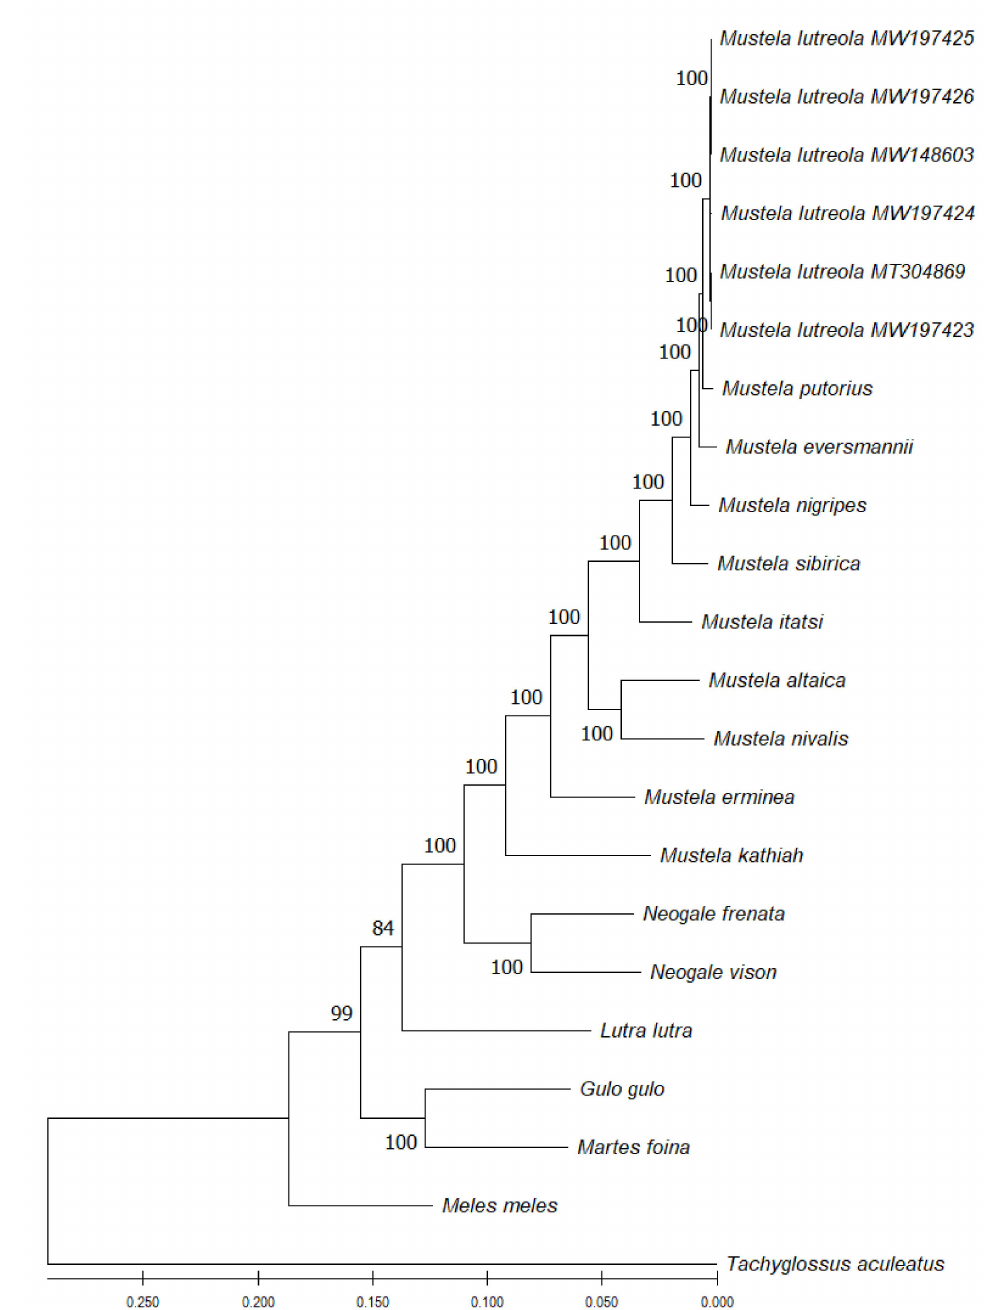
Figure 11. Phylogenetic tree generated by the Maximum Likelihood method and Tamura-Nei model in MEGA 11 based on complete mitochondrial genome sequence alignments of 11 reference sequences in the genus Mustela (six individuals of M. lutreola —the present study, M. putorius HM106318, M. eversmanii NC_028013, M. nigripes NC_024942, M. sibirica MN206976, M. itatsi NC_034330, M. altaica NC_021751, M. nivalis MF459691, M. erminea MW257230, M. kathiah HM106320, M. frenata HM106321), five other species of the mustelid family ( Neogale vison NC_020641, Lutra lutra NC_011358, Gulo gulo NC_009685, Martes foina NC_020643, Meles meles NC_011125) and an outgroup species ( Tachyglossus aculeatus AJ303116). The percentage of replicate trees in which the associated taxa clustered together in the bootstrap test (1000 replicates) is shown next to the branches. The tree is drawn to scale, with branch lengths measured in the number of substitutions per